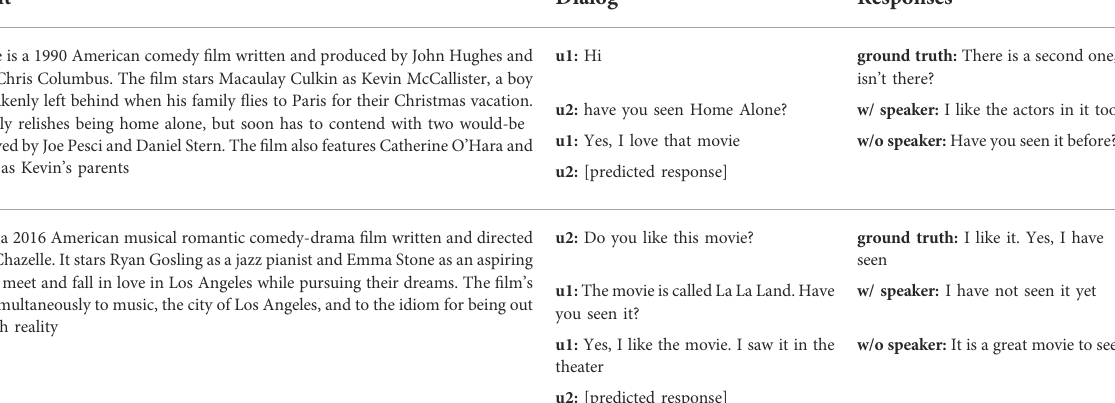
TABLE 10 Sample responses of model variants. Document Dialog